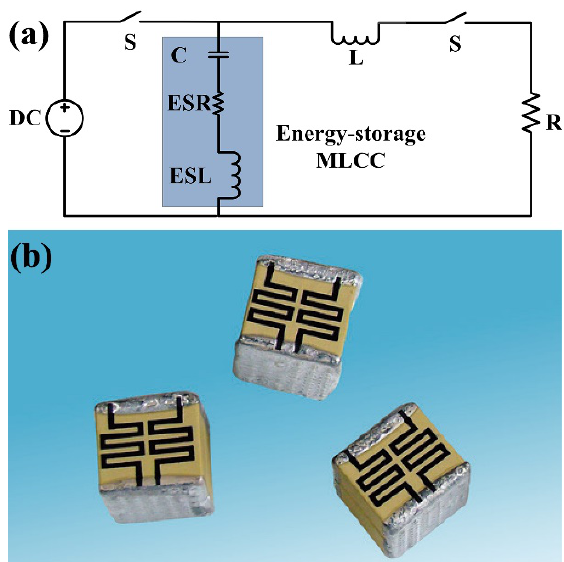
Fig. 35 (a) Simplified schematic of a pulsed power circuit using MLCC as the energy-storage element. (b) High- energy-density Novacap MLCCs for pulsed power based on PLZT antiferroelectric materials developed by the Knowles Capacitors company. Reproduced with permission from Ref. [151], © Knowles Precision Devices